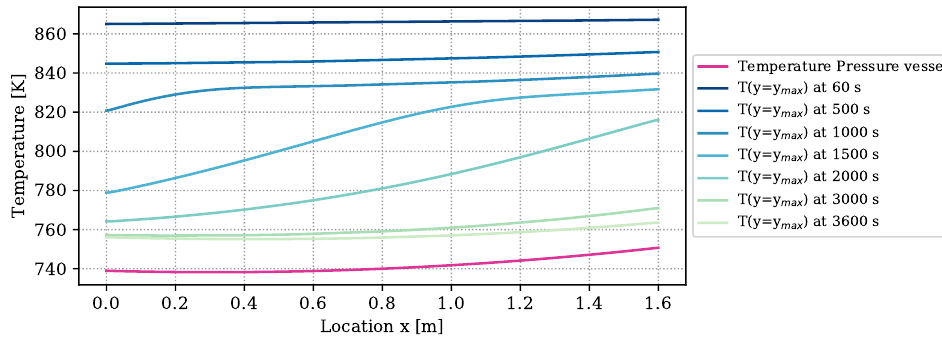
Figure 4. Temperature distribution of the outer pressure vessel according to the parameters k 1 –k 3 and at the top boundary of the reactive bed over the reactor length at different times simulated with the DuMu x -model with the parameters of Table